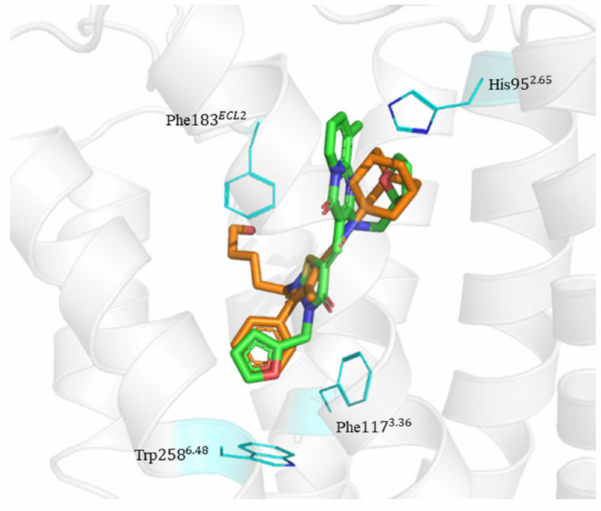
Figure 4. The binding mode of Compound 8 in the orthosteric site of CB2 receptor. Protein, AM10257, and Compound 8 are shown as a gray cartoon, orange stick, and green stick, respectively. The side chains of His95 2.65 , Phe117 3.36 , Phe183 ECL2 , and Trp258 6.48 are represented as lines in blue